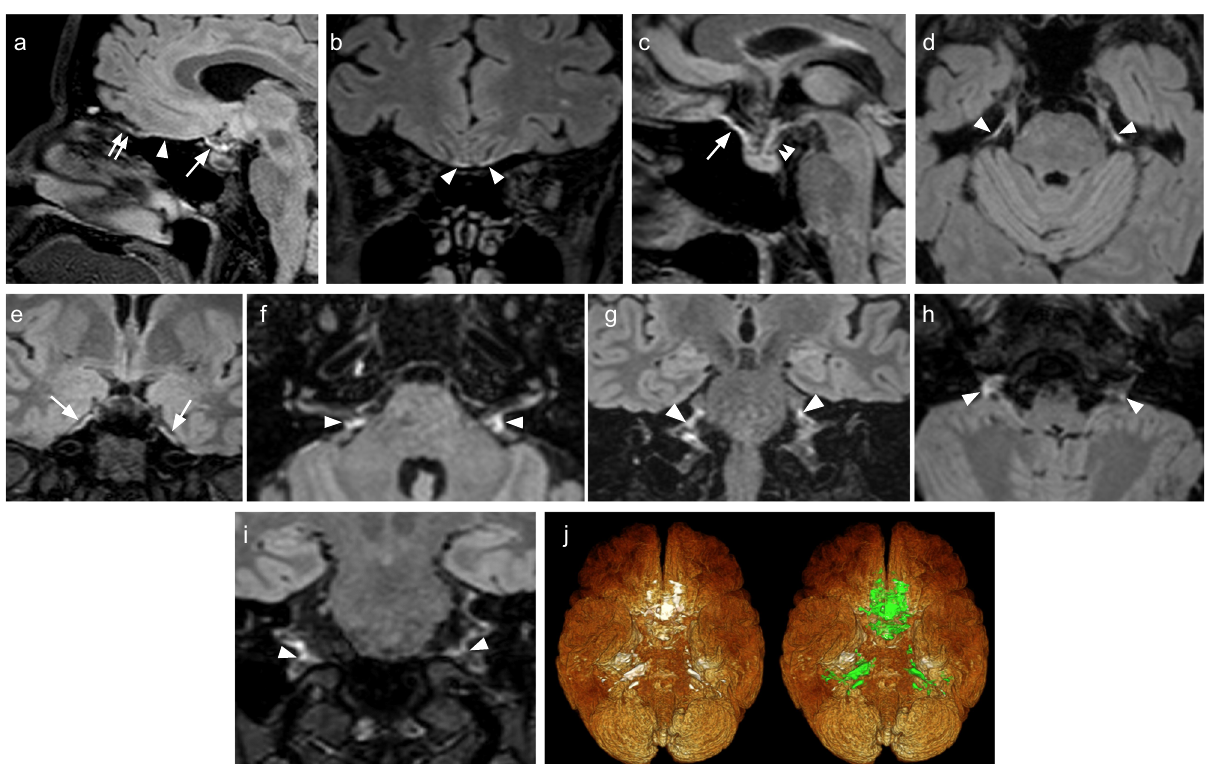
Fig. 4 Ventral dural lymphatic system MR images and metrics from multiple subjects. a – c FLAIR images show the ventral dural lymphatic elements in the anterior cranial fossa (arrowheads), olfactory bulb (double arrow), optic grove (arrows) and diaphragma sella (double arrowhead; c ). d , e Ventral dural lymphatic elements can be seen at the level of the ori fi ces of neural foramina of the trigeminal nerves ( d , arrowheads) and edge of Meckel ’ s cave dura (arrows; e ). Ventral dural lymphatic elements can also be seen at the level of the ori fi ces of the internal auditory canals on axial ( f , arrowheads) and coronal ( g , arrowheads) views. These structures are visible as well at the level of the jugular foramina around the IX – XI complex (arrowheads) on axial ( h ) and coronal ( i ) and views (arrowheads). j 3D representation of ventral dural lymphatics as de fi ned from T2-FLAIR shown from ventral view. The ventral dural lymphatics (bright ventral irregular structures around the ventral dural surfaces and neural foramina) as de fi ned from T2-FLAIR and co-registered with rough segmentation of the brain and the dural lymphatics